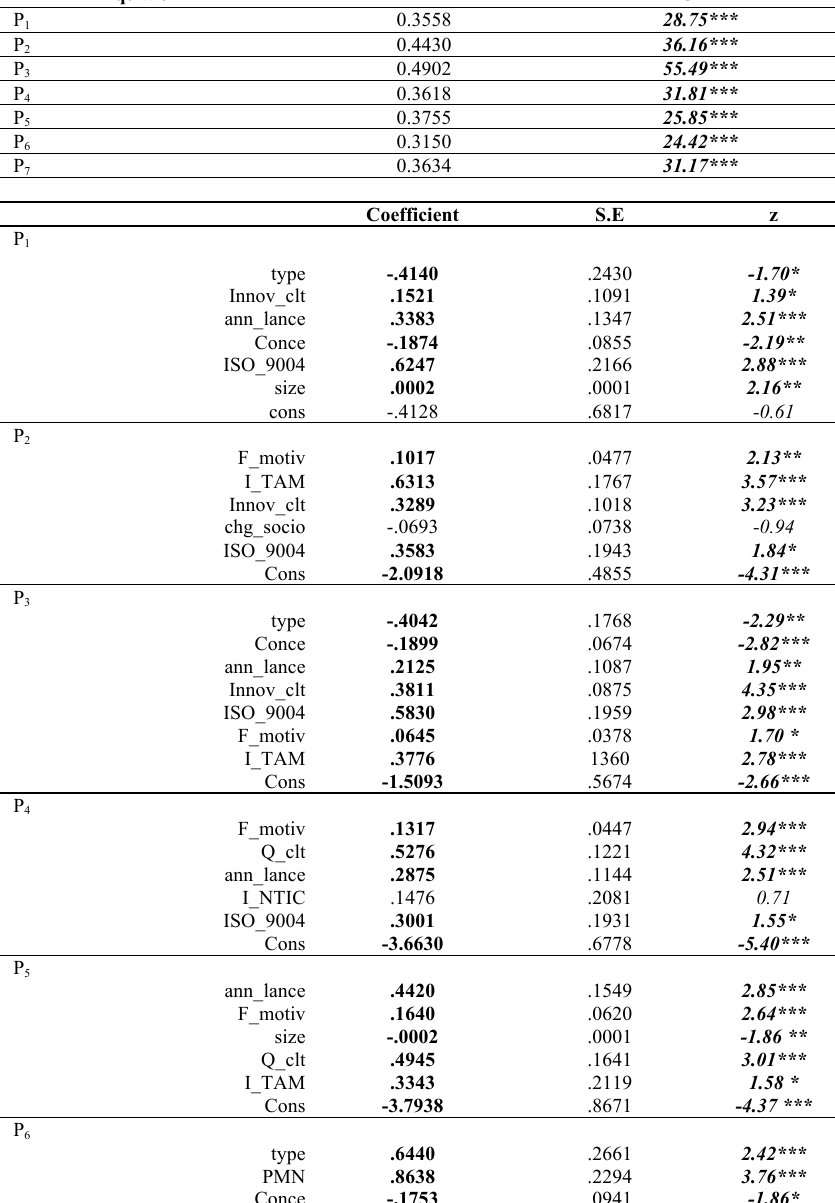
Table 2. Regression by the SUR